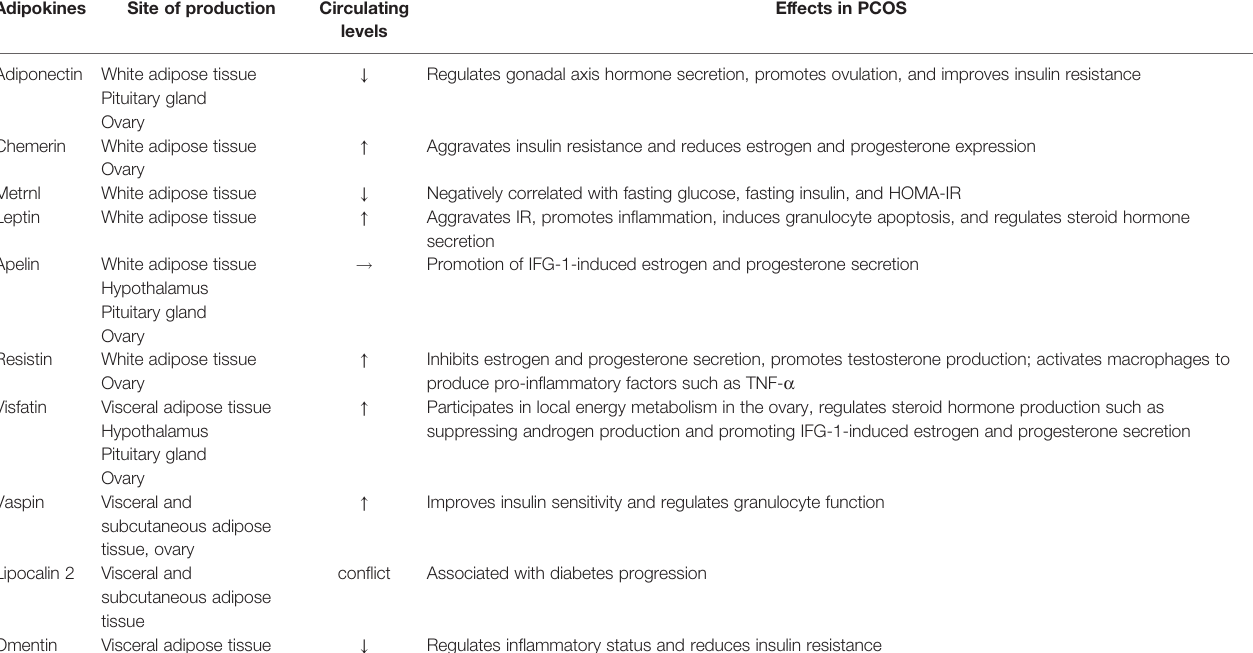
TABLE 1 | Adipokines and their main effects in